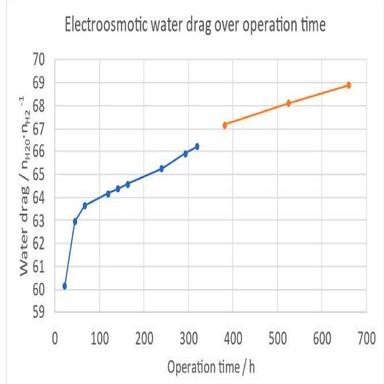
Water drag through the membrane over operation time.